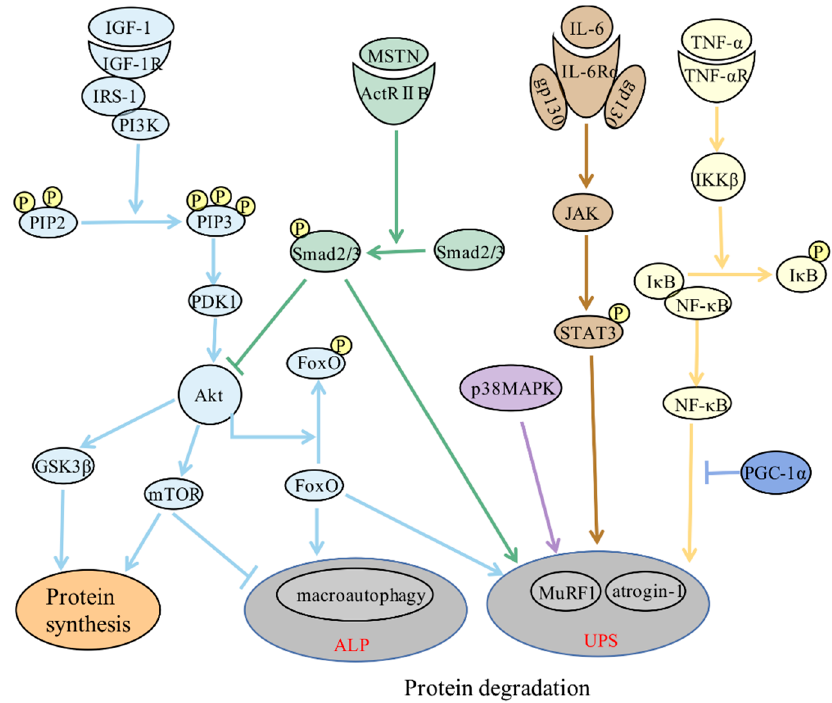
Figure 1. Molecular mechanisms of muscle